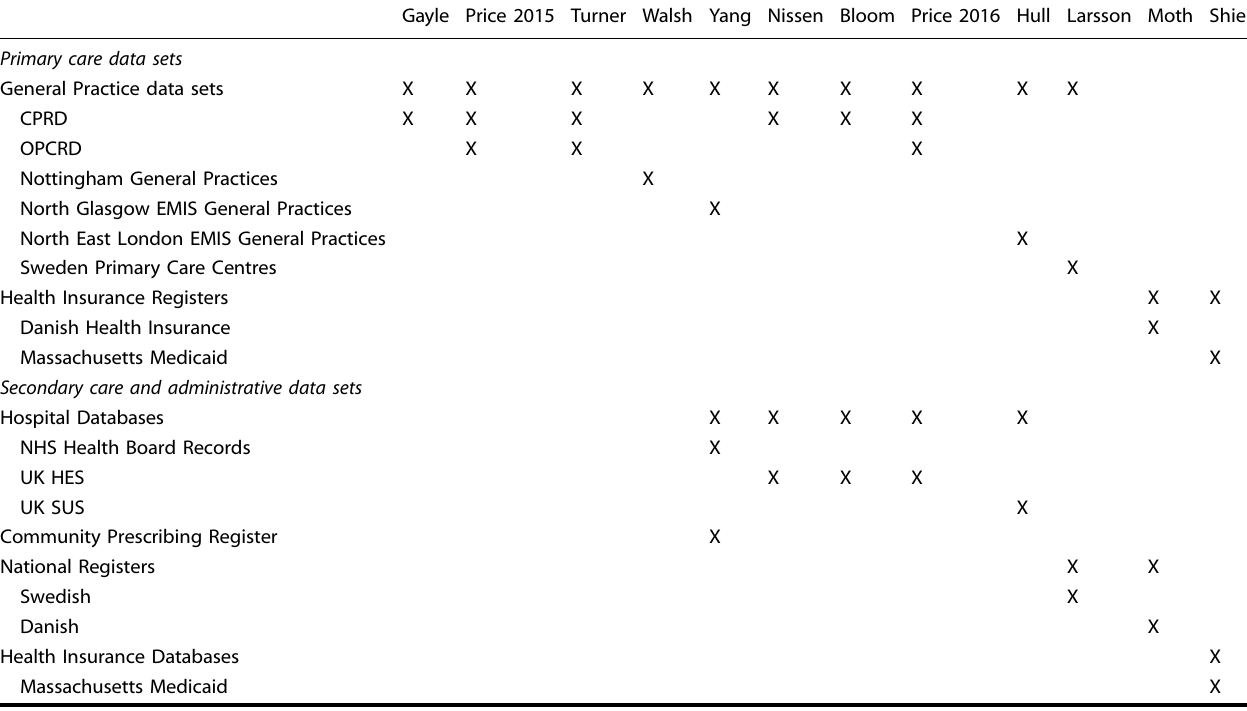
Table 1. Primary care, secondary care and administrative data sets used by the included